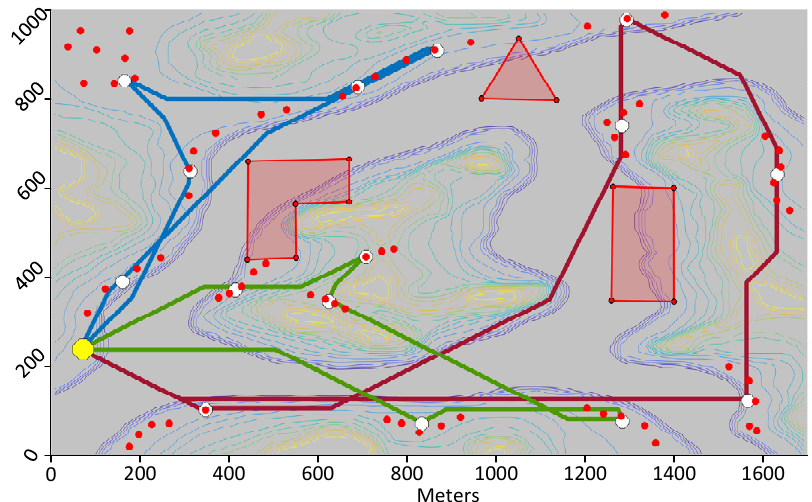
Figure 9. Paths minimizing distance for three UAVs visiting 15 DPs covering the 70 sensors.